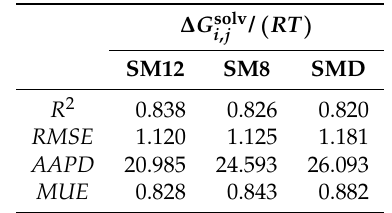
Figure 2. Parity plot of the predicted versus reference values of the negative dimensionless solvation free energy, − ∆ G solv / ( RT ) , using the SM12, SM8, and SMD universal solvent model, as indicated. i , j The blue lines corresponds to the y = x line, and the dashed blue lines correspond to ± 1.1 and are drawn as a reference; the value of 1.1 was used based on the RMSE for the SM12 predictions. The reference values are from the Minnesota Solvation Database. Table 2. A summary of the squared correlation coefficient ( R 2 ), root mean square error ( RMSE ), average absolute percent deviation ( AAPD ), and mean unsigned error ( MUE ) for the values of ∆ G solv / ( RT ) predicted using the SM12, SM8, and SMD universal solvent model as compared to i , j the reference data from the Minnesota Solvation